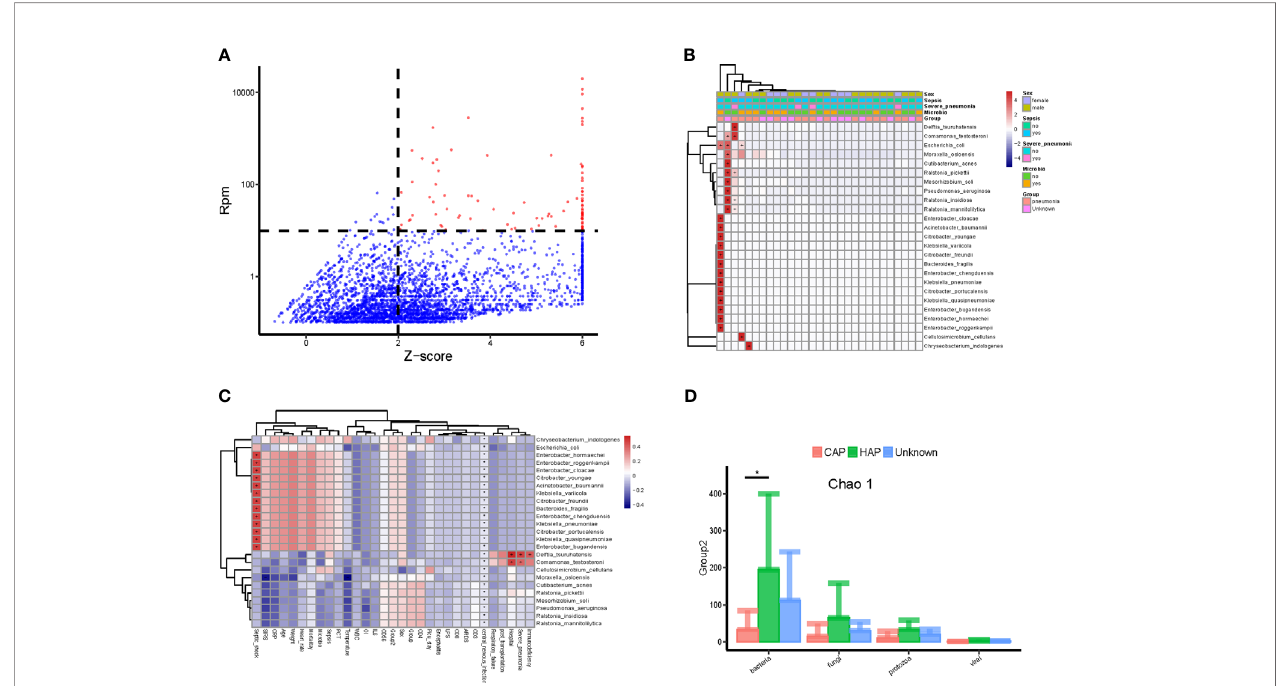
FIGURE 2 | Potential pathogenic bacteria in the bloodstream of children with suspected sepsis in PICU. (A) Identi fi ed bloodstream pathogenic bacteria, where red dots represent potential pathogenic bacteria, Z-score > 6, uniformly assigned value was Z-score = 6. (B) Heat map of bloodstream potential pathogenic bacteria; each line on the horizontal represents a sample and lines on the vertical represent potential pathogenic bacteria; the “ + ” and “ - ” signs represent signi fi cant positive and negative correlations, respectively; the top is the clinical phenotype, and the color block on the right represents the speci fi c value of clinical phenotype. (C) The correlation between bloodstream pathogenic bacteria and clinical phenotype; each line on the horizontal represents a clinical phenotype and on the vertical represents potential pathogenic bacteria; the “ + ” and “ - ” represent signi fi cant positive and negative correlations, respectively; the color block on the right represents the value of the correlation coef fi cient: positive correlation is red and negative correlation is blue. (D) The species richness (chao 1) of hospital-acquired pneumonia (HAP) bacteria was signi fi cantly higher than that of community-acquired pneumonia (CAP), P < 0.05, Wilcoxon rank- sum test. *P <